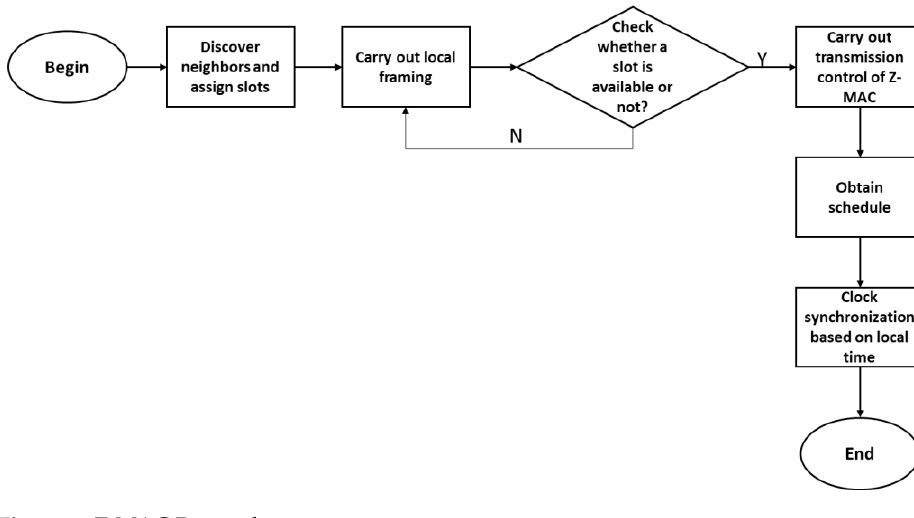
Figure 4. Z-MAC Protocol.